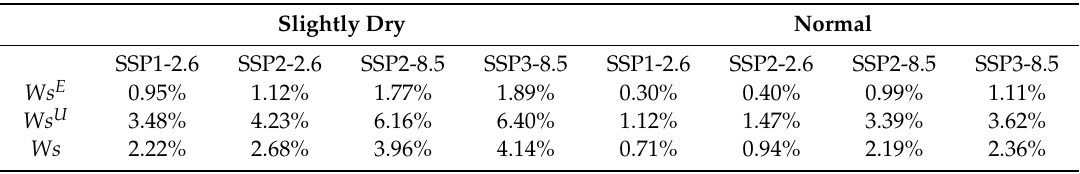
Table 7. Reduced water stress after